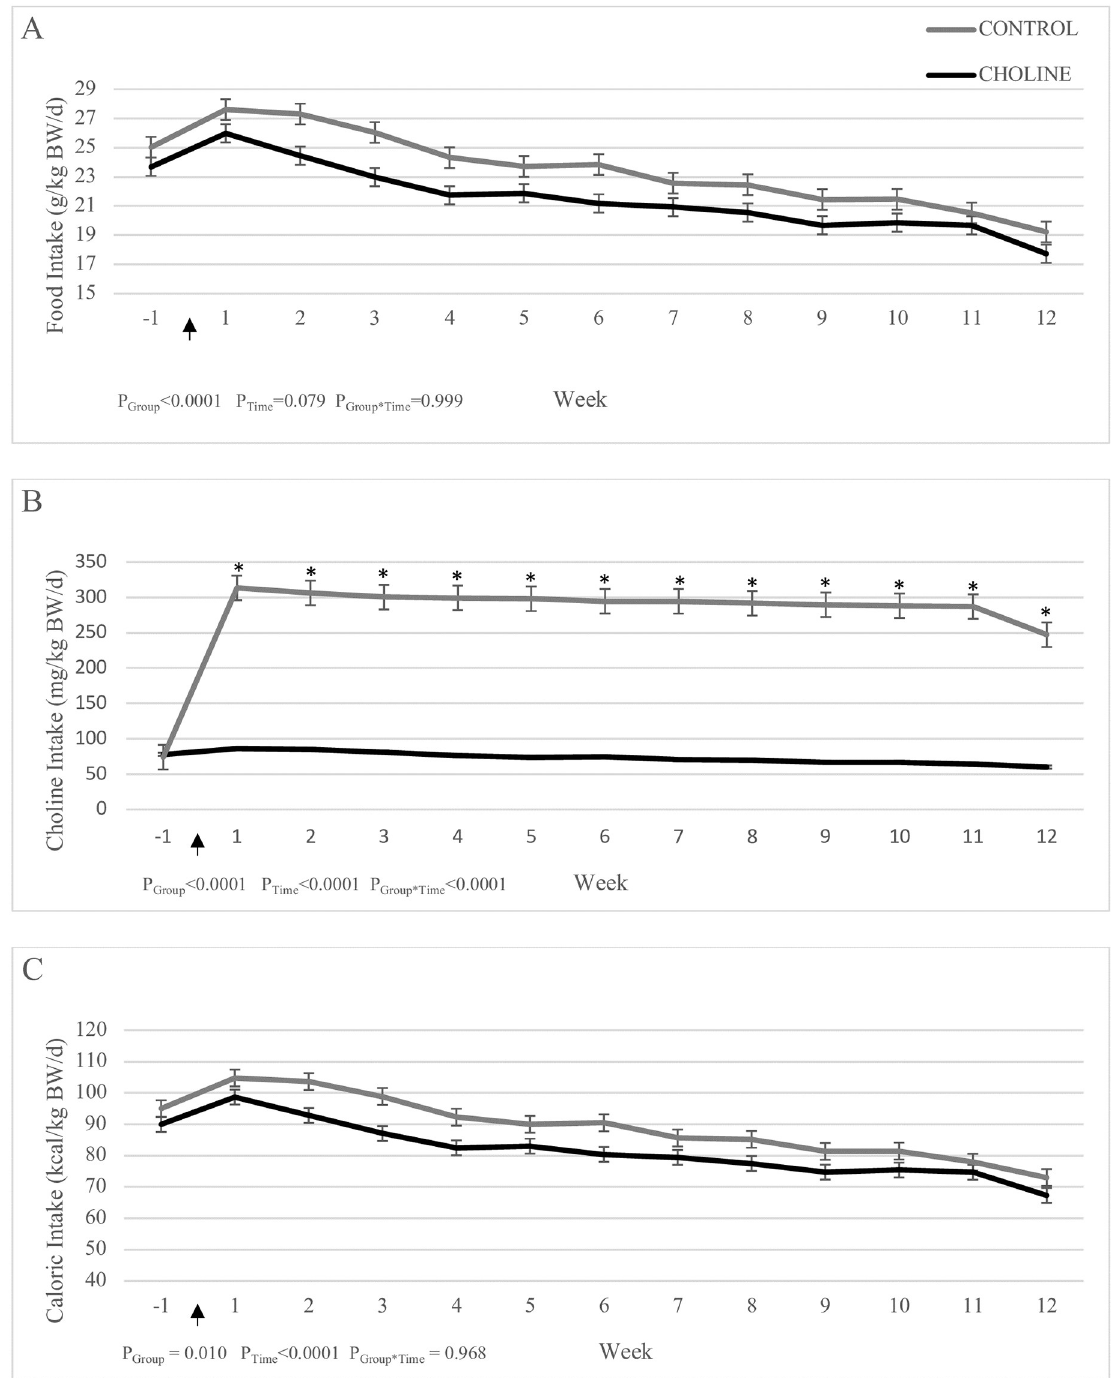
Fig 1. Daily food intake (A), daily choline intake (B), and daily calorie intake (C) of post-gonadectomy kittens supplemented with additional choline (CHOLINE, n = 8) for 12 weeks compared to a group fed only the base diet (CONTROL, n = 7). Gonadectomy occurred at Week 1